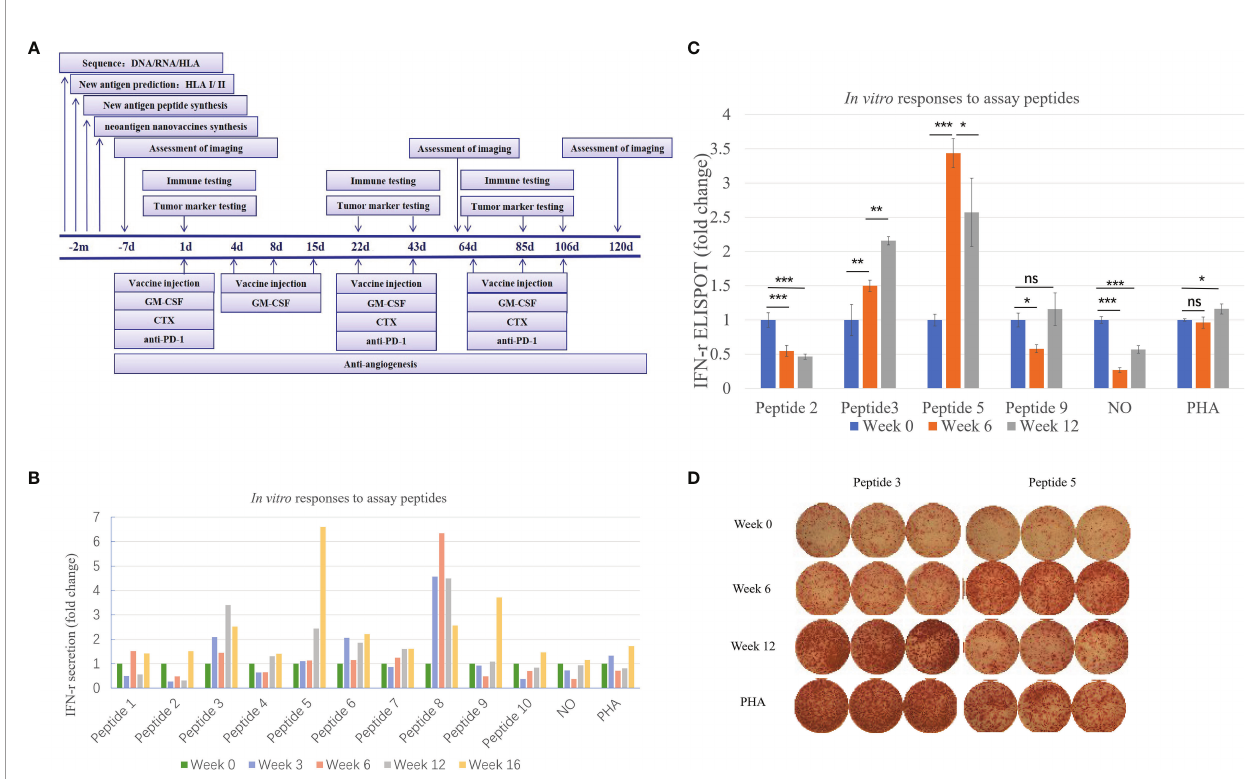
FIGURE 2 | Immune monitoring of vaccination-induced peripheral blood T-cell response. Peripheral blood mononuclear cells (PBMCs) collected prior to vaccination (Week 0) and at Weeks 6 and 12 post-vaccination were assessed for peptide-speci fi c T-cell recognition using three assays (some tests were conducted at Week 3 and Week 16). (A) Flowchart of vaccine treatment. (B) Summary of IFN- g ELISA results showing the change in peptide-speci fi c IFN- g secretion by pre- and post- vaccine patient PBMCs following culture with vaccine or control. See Table 1 for peptide designation codes and full peptide sequences. (C) Summary of IFN- g ELISpot results showing the change in peptide-speci fi c IFN- g -producing PBMCs compared with pre-vaccine levels. (D) IFN- g ELISpot results for the two mutant peptides compared with PHA controls. Statistical analyses were performed using Fisher ’ s least signi fi cant difference. *p < 0.05, **p < 0.01, ***p < 0.01. ns, not signi fi